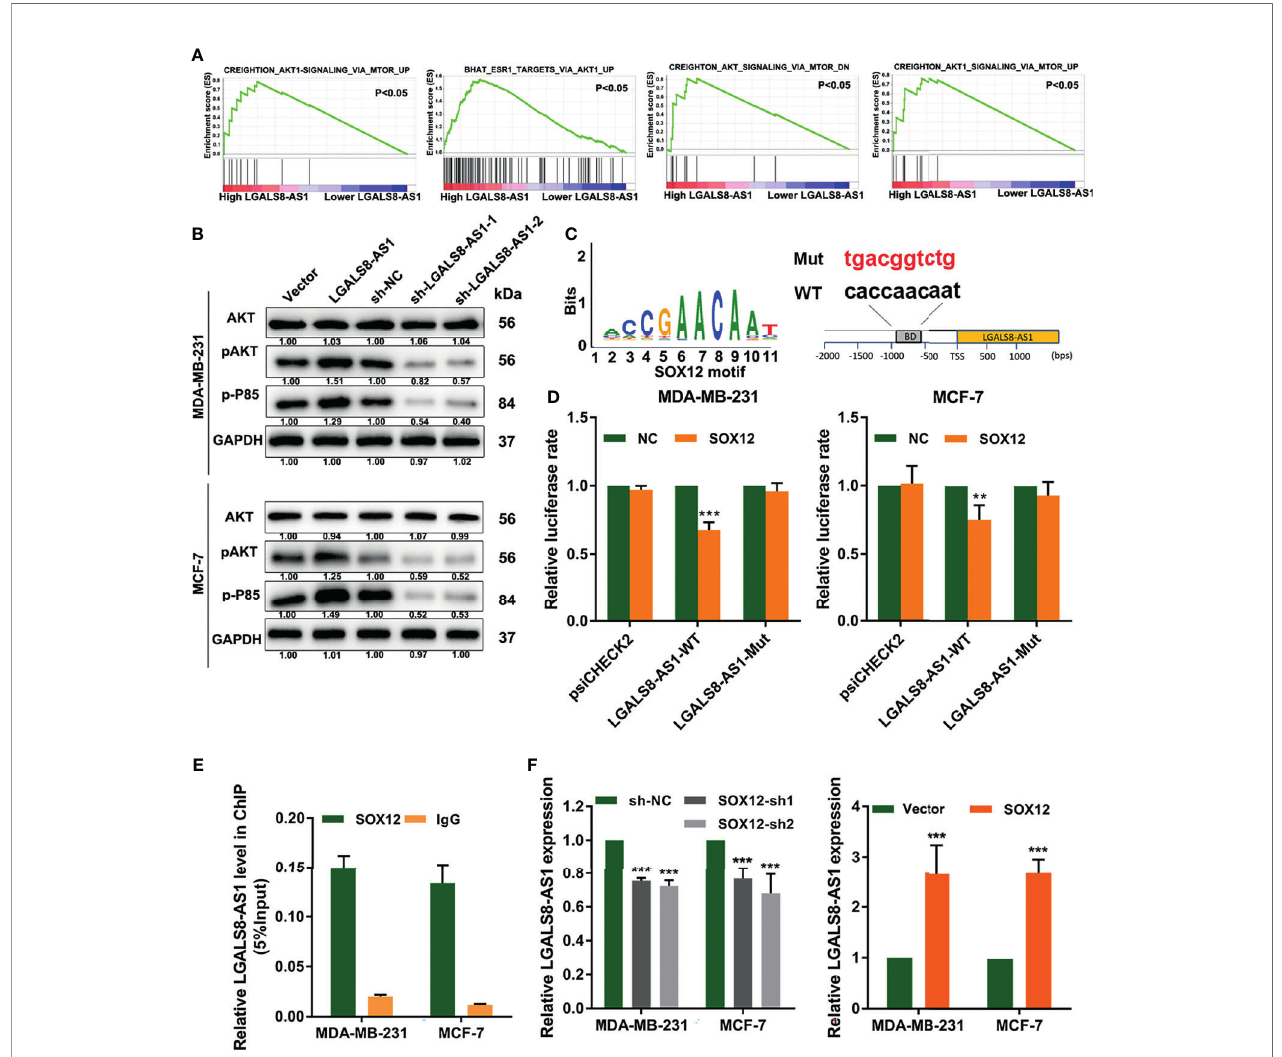
FIGURE 7 | LGALS8-AS1 activated the PI3K/AKTsignalingpathway andis feedbacktranscriptionally regulatedby SOX12. (A) Gene set enrichment analysis(GSEA) revealed that LGALS8-AS1 expression was related to the PI3K/AKTsignalingpathway inbreast cancer. (B) Effect of LGALS8-AS1 onthe expressionsof PI3K/AKT signaling-related proteins detected byWestern blot assay inMDA-MB-231 and MCF-7 cells. (C) The SOX12 motifbinding to the promoter of LGALS8-AS1 predicted by JASPAR. (D) Luciferaseactivities inMDA-MB-231 and MCF-7 cells after co-transfection of the SOX12 overexpression plasmid together with thewild-typeormutated LGALS8-AS1. (E) Chromatin immunoprecipitation (ChIP) assay demonstrating the direct binding of SOX12 to the LGALS8-AS1 promoter in MDA-MB-231 and MCF-7 cells. (F) Effect ofSOX12 on the expression of LGALS8-AS1 detected inMDA-MB-231 and MCF-7 cellsbyreal-time quantitative PCR (RT-qPCR).** p < 0.01, *** p <